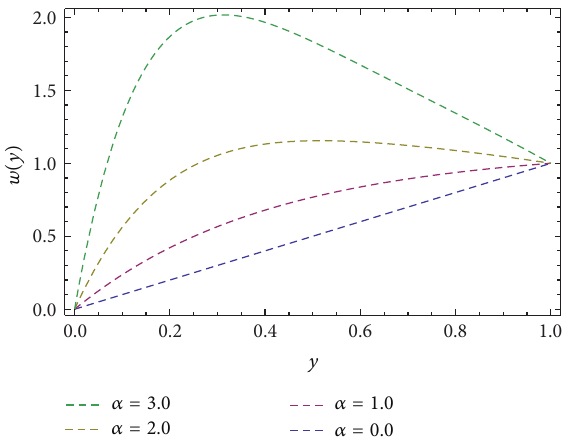
Figure 3: Velocity profile 𝑤(𝑦) for different values of 𝛼 , keeping 𝜕𝑃/𝜕𝑧 = −0.5 , 𝛽 = 1.0 , and 𝜙 = 45 ∘ .